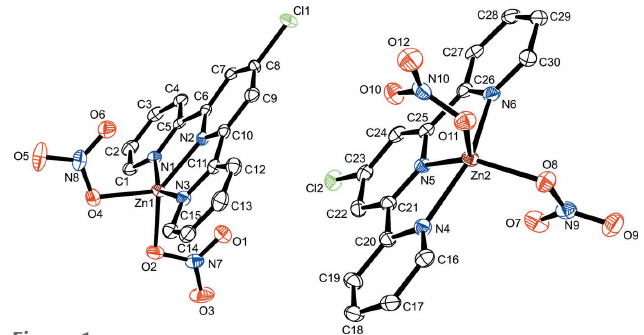
Figure 1 The molecular structure of the title compound with displacement ellipsoids drawn at the 50% probability level; H atoms are omitted for clarity.